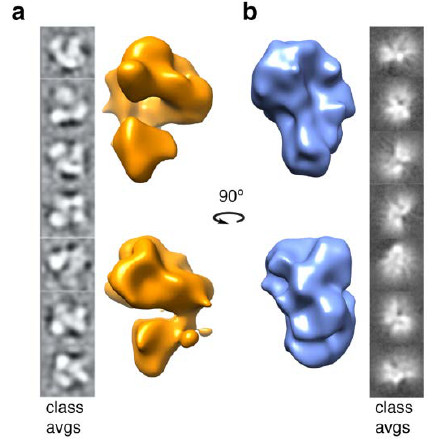
Figure 4. Preliminary 3D reconstructions and corresponding class averages of apo-TAFs and TAFs–DNA complexes. ( a ) apo-TAF complex (orange) showing the distinct horseshoe-shaped 3-lobed structure. ( b ) TAFs in complex with ~200 bp of RPS5 promoter (blue) showing a globular nucleosome-like core structure with extra density around the entire molecule, which we attribute to the wrapping of DNA by the TAFs. These preliminarily 3D reconstructions indicate a visually distinct di ff erence between the DNA bound and unbound TAF